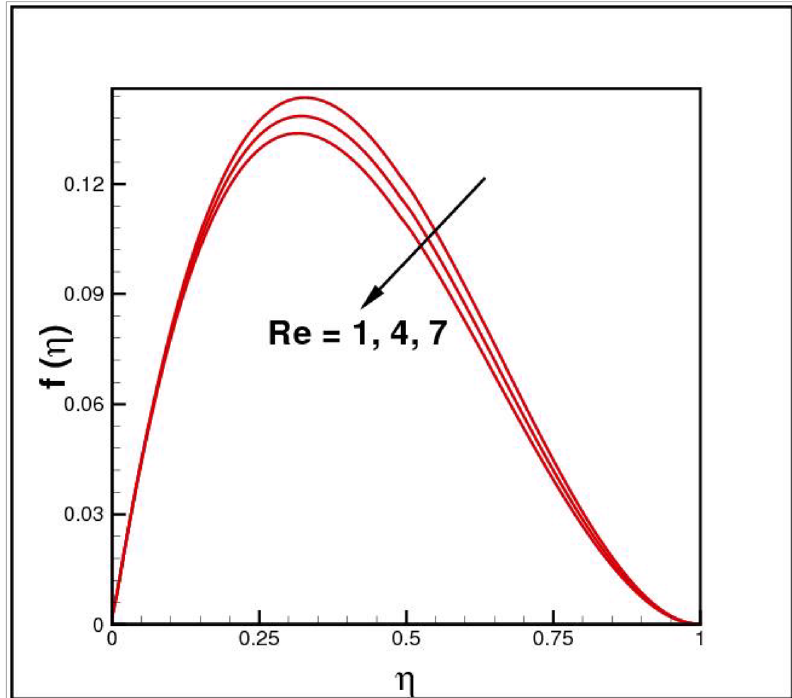
Figure 3. Impact of Re on f ( η ).